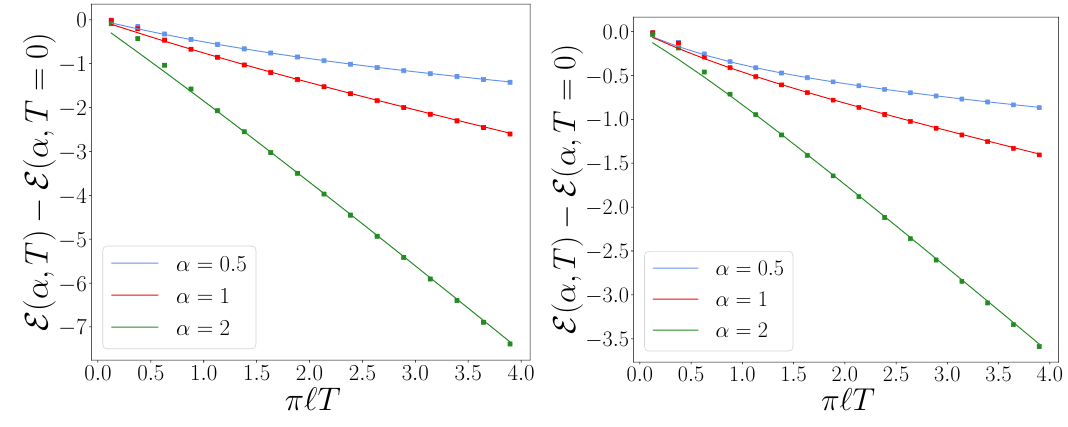
Figure 6: The charged logarithmic negativity for a bipartite geometry in the infinite- line (left) or semi-infinite (right). We set L = 200. Analytical prediction in Eqs. (127) and